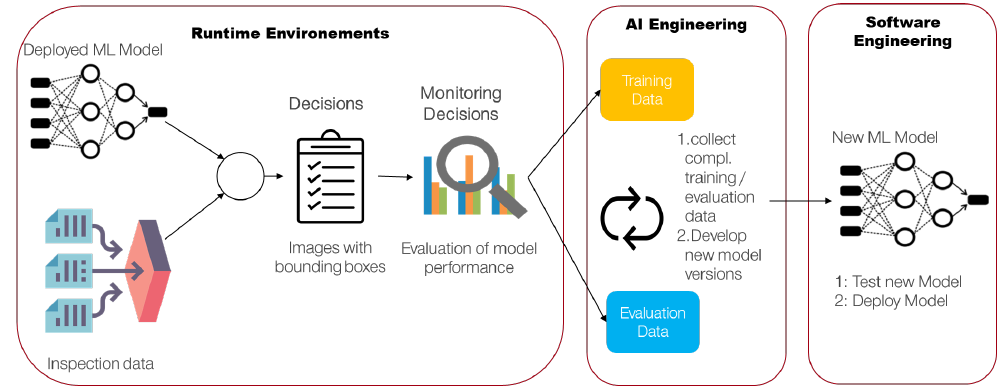
Figure 7. Model and Data Life-Cycle in the SDLC for TRL9 solutions.